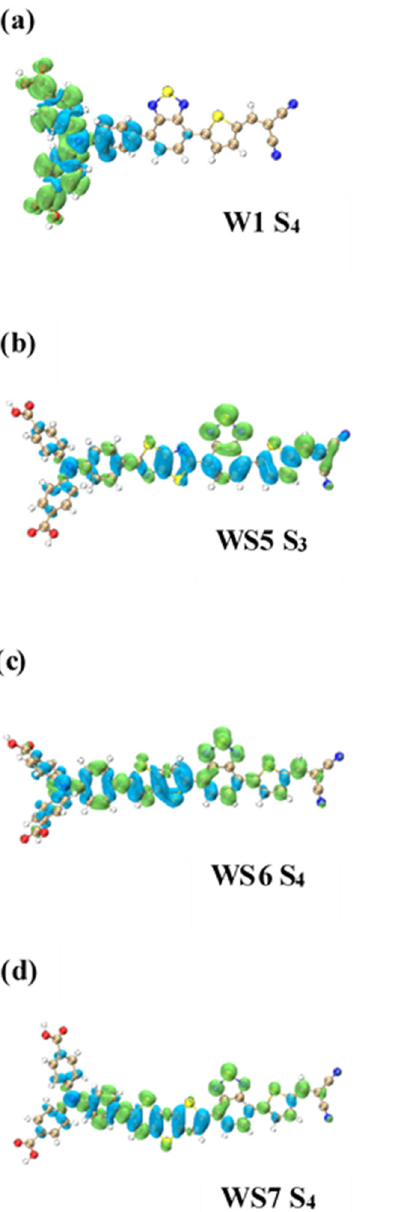
Figure 6. TDM and CDD of ( a ) S 4 of W1, ( b ) S 3 of WS5, ( c ) S 4 of WS6, and ( d ) S 4 of WS7 in the OPA process.